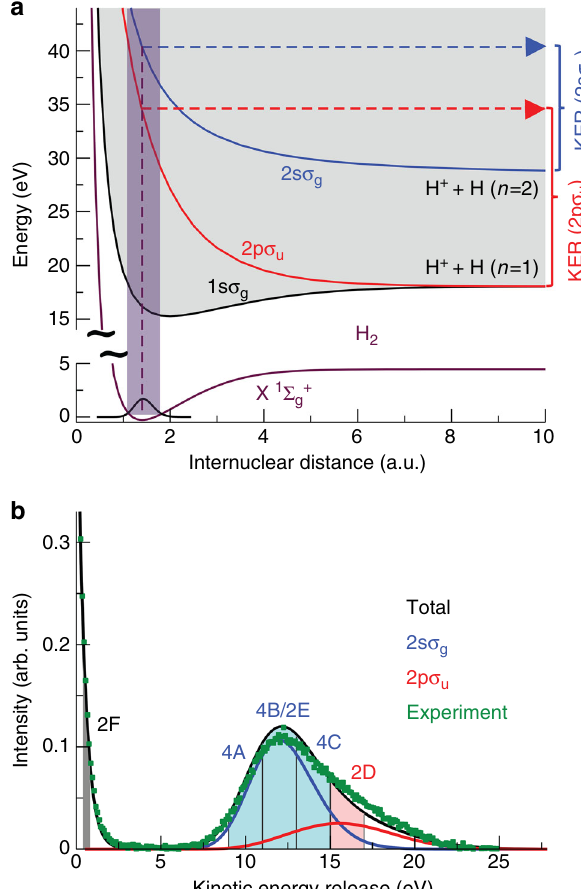
Fig. 3 Correlation diagram and kinetic energy distribution for dissociation of H þ 2 a Potential energy curves for the ground state of H 2 (lower curve) and the 1 s σ g , 2 s σ g , and 2 p σ u ionization thresholds (upper curves). The latter correspond to electronic states of H þ . The violet shaded area represents 2 the Franck-Condon region associated to the ground vibrational state of H 2 . Notice the break in the energy scale for a better visualization. The dashed violet line shows how the initial internuclear distance of the molecule is mapped onto the kinetic energy release (KER) of the reaction applying the ” re fl ection approximation ” 9 . b KER distribution obtained after single- photon ionization of H 2 employing photons of h ν = 400 eV. Symbols: experiment, lines: theory. The calculation depicted by the black curve includes the twelve states with the highest photo ionization cross sections (up to n = 4). The main contributions (besides 1 s σ g at low KER) are shown in blue (2 s σ g ) and red (2 p σ u ), others are not visible on that scale. The shaded areas indicate the regions of KER selected in Figs. 2d – f and 4a,